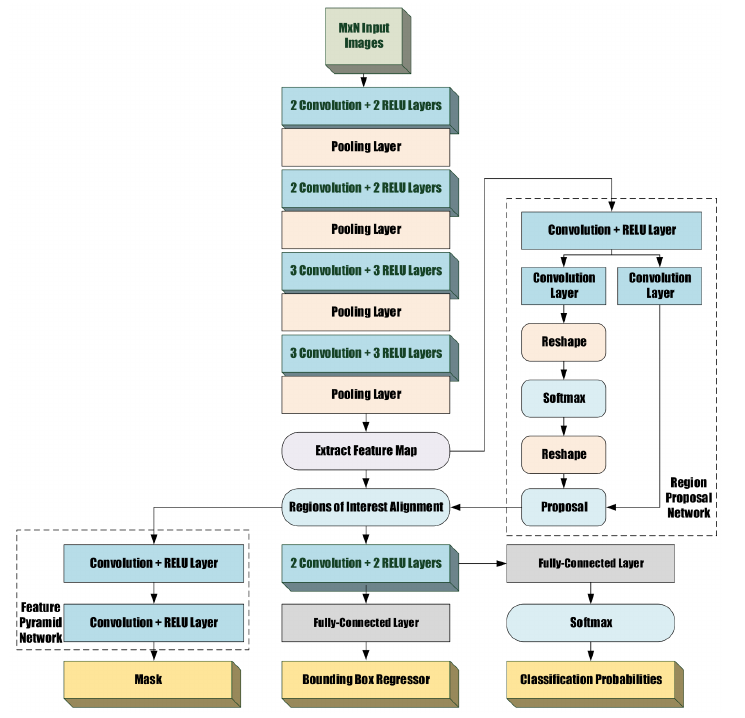
Figure 4. The structure of the Mask R-CNN